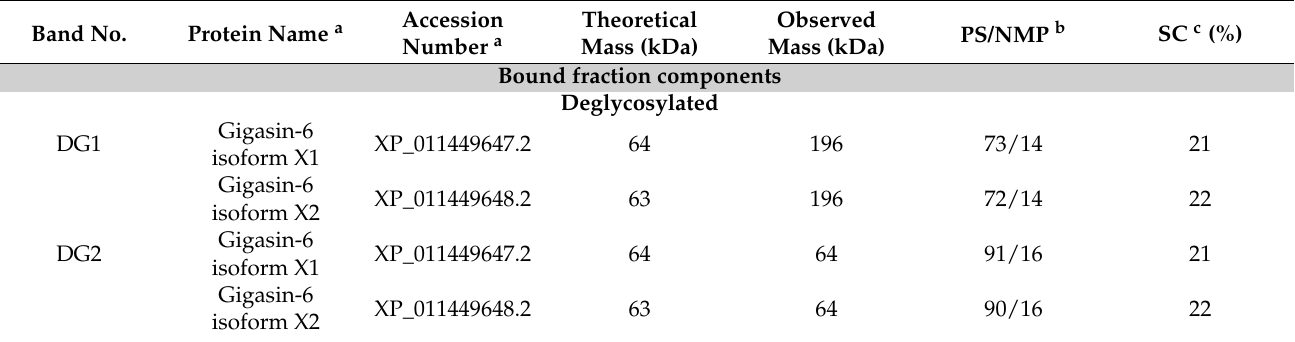
Figure 3. Phosphoprotein detection. Ten µ g of the sample was loaded on each lane and stained with Pro-Q Diamond for phosphoproteins. Abbreviations: FD, Freeze-dried CgSE, AD, Air-dried CgSE; UF, Unbound Fraction; BF, Bound Fraction; UB1-UB3, B1, B2, S1, and S2 bands correspond to the identified proteins in the mass spectrometry analyses and are summarized in Table 1. This figure was created using BioRender.com (accessed on 25 July 2022). Table 2. MS/MS-based identification and characterization of the protein band containing the deter- mined N -glycosylation sites of Gigasin-6 isoform X1 and/or X2 in the WGA column-bound fraction (BF) after treatment with PNGase